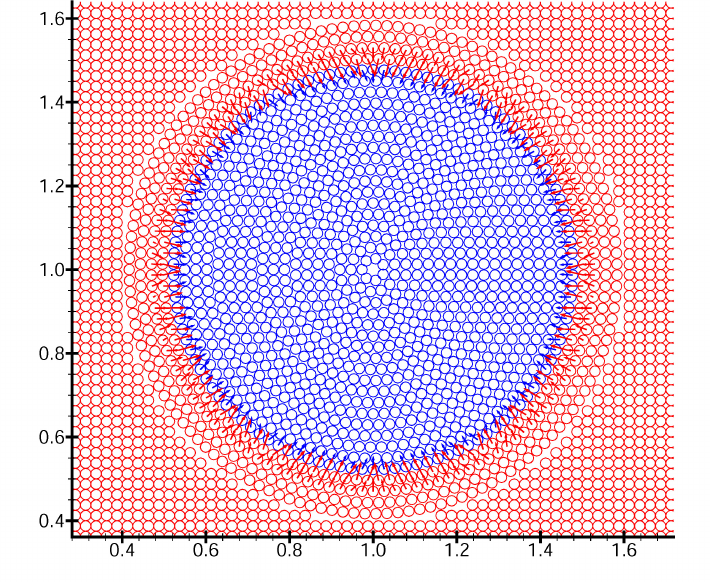
Figure 1. Sketch of particle-scale surface tension force on the interface of the internal bubble and the surrounding